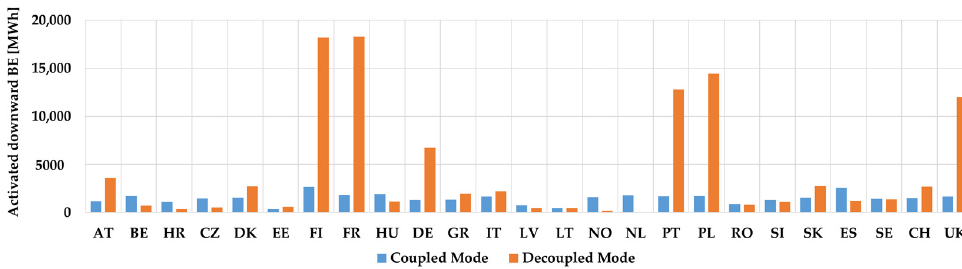
Figure 16. Activated downward BE in each participating control area.